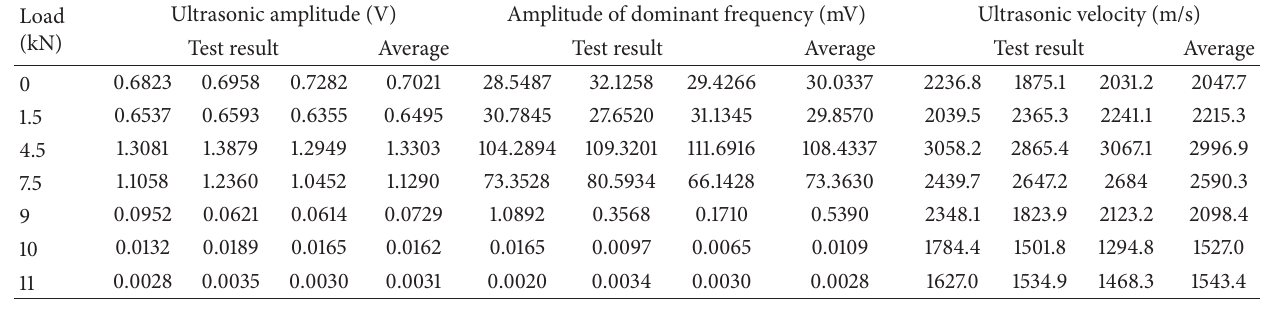
Table 3: The response result of ultrasonic parameters.